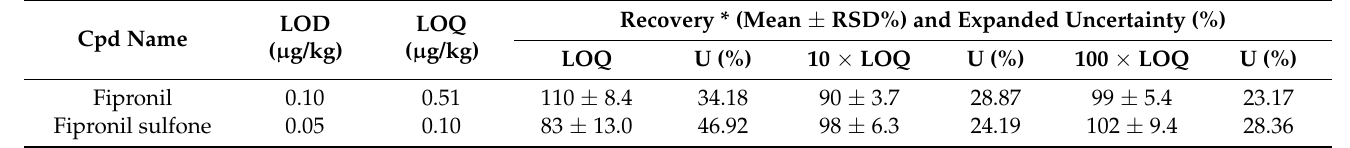
Table 2. LOD, LOQ, recoveries, and expanded uncertainty of fipronil and fipronil sulfone spiked at different concentrations. Cpd